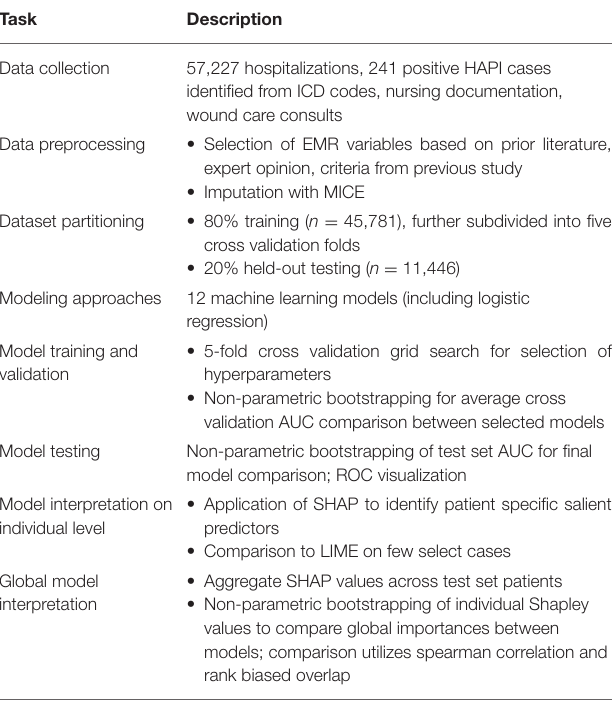
TABLE 1 | Overview of methods for HAPI prediction and